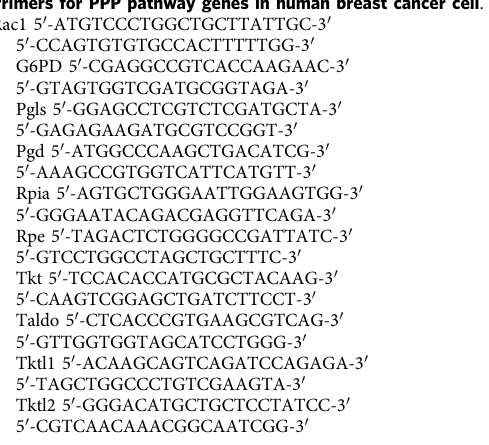
Fig. 8 siRac1/DDP NPs recovers the chemosensitivity of PDXs derived from NAC resistant TNBC patients. a Cy5-siRac1/DDP NPs showed much longer blood circulation half-life than the naked Cy5-siRac1. Bar graphs represent the mean ± SD of three independent experiments. b Cy5-siRac1/DDP NPs speci fi cally concentrated in the breast tumors compared with the naked siRac1. The mice were killed at 24 h post injection of the naked Cy5-siRac1 and Cy5-siRac1/DDP NPs and then the biodistribution of the Cy5-siRac1 in the tumors and major organs of the PDX-bearing mice were detected. Bar graphs represent the mean ± SD of three independent experiments. c – e Tumor growth curves ( c ), tumor images ( d ), and tumor weights ( e ) of the PDXs from NAC resistant TNBC patients after systemic treatment with PBS, blank NPs, NPs loading siRac1 (siRac1 NPs), NPs loading DDP prodrug (DDP NPs), and siRac1/ DDP NPs. Starting points of intravenous injections are indicated by the arrows. Tumors ( n = 6 per group) were harvested at indicated days post injection. (Growth curve: control vs DDP NPs p < 0.0001, DDP NPs vs siRac1/DDP NPs p < 0.0001. two-way ANOVA + Dunnett ’ s post hoc tests. Tumor weight NPs vs DDP NPs p = 0.0006, DDP NPs vs siRac1/DDP NPs p < 0.0001, two-sided unpaired t -test). f – j Immunohistochemistry analysis of the PDX tissues after systemic treatment in each group. Rac1 ( f ), p-ERK ( g ) γ H2AX ( h ), Ki67 ( i ), CC3 ( j ). Scale bar, 20 μ M. Each group n = 5. ( g : NPs vs siRac1 NPs p <